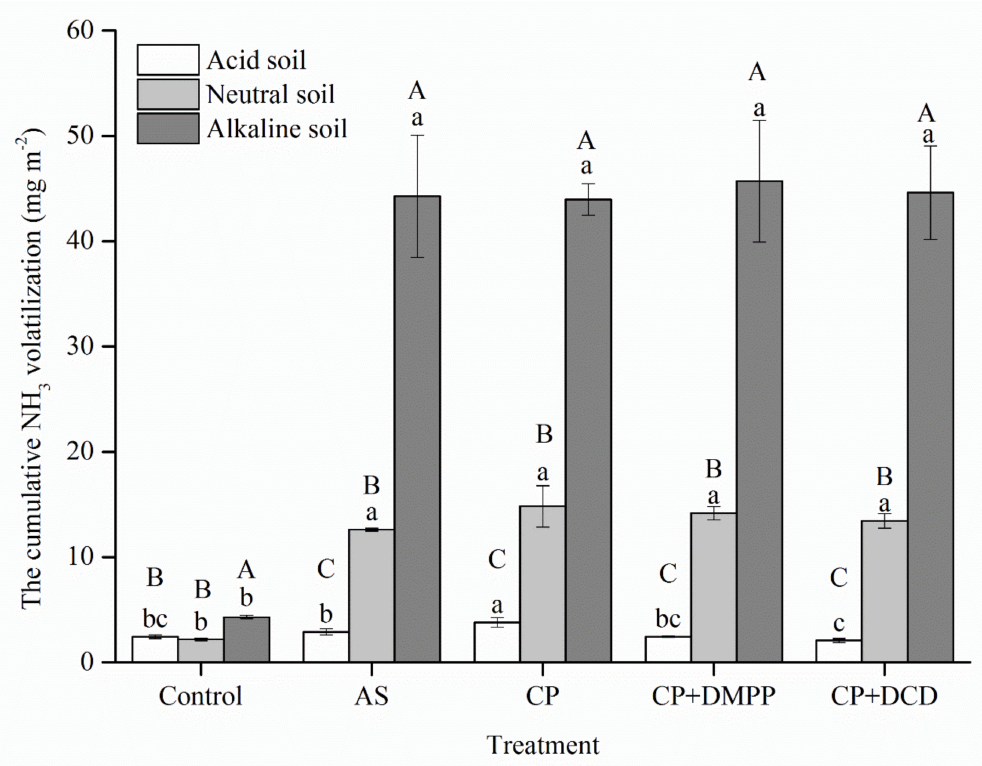
Figure 5. The cumulative ammonia volatilization of different treatments in the acid, neutral, and alkaline soils. Error bars represent standard deviations (n = 3). The different lowercase letters above the figures indicate significant differences between different treatments within the same soil at p < 0.05 by Tukey’s test; the different capital letters above the figures indicate significant differences between different soils in the same treatment at p < 0.05 by Tukey’s